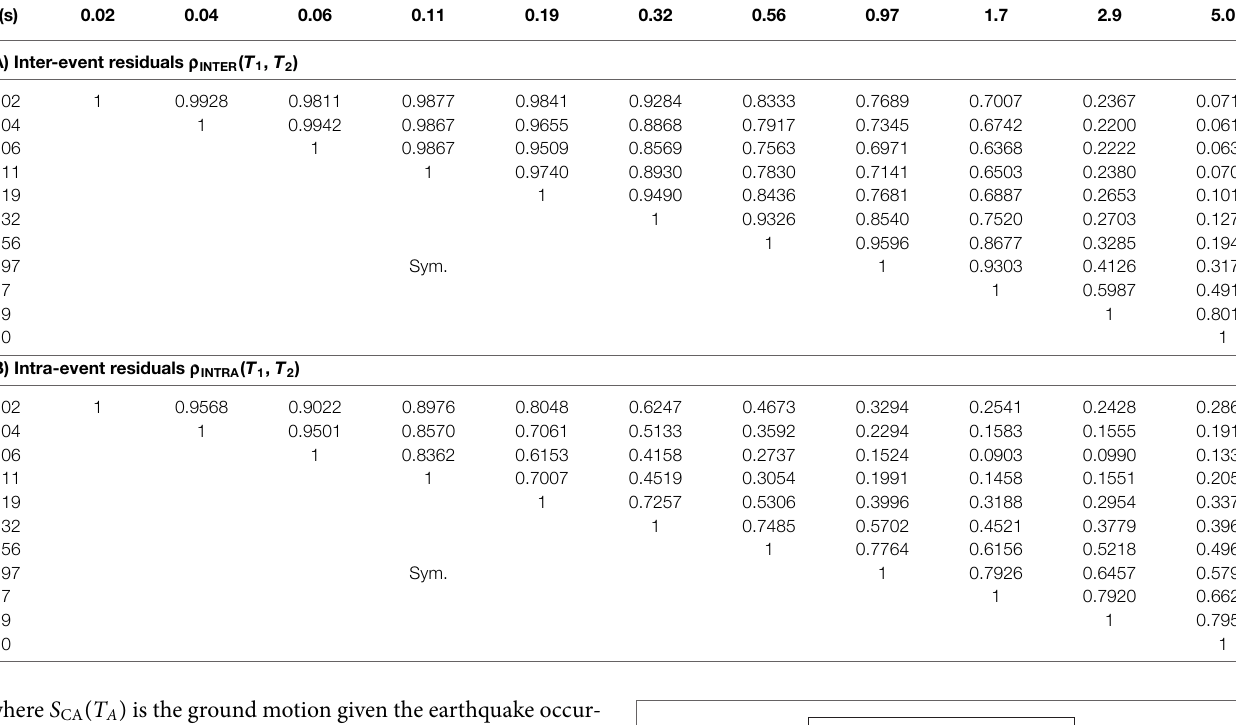
TABLE 2 | Period-to-period correlation for inter-event and intra-event residuals (Itoi et al., 2015) .